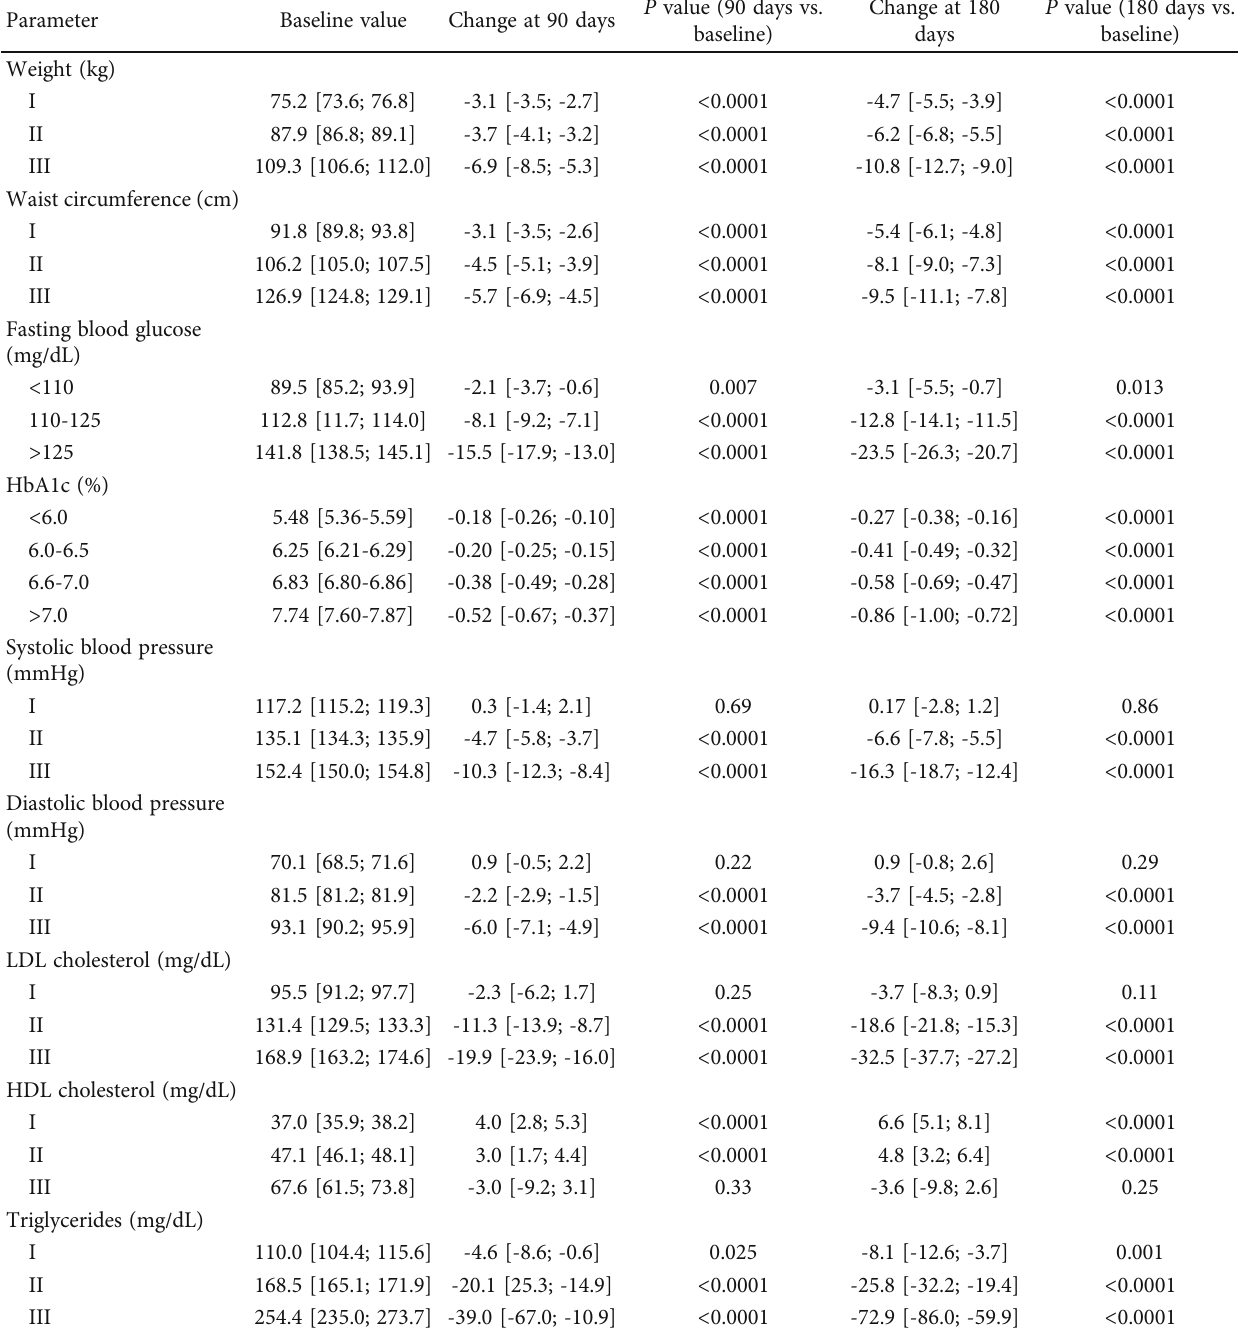
Table 3: Estimated marginal means (95% CI) of the parameters of interest at baseline and their change after 90 days and 180 days of treatment, by tertiles of baseline values or clinically meaningful classes (for FBG and HbA1c).